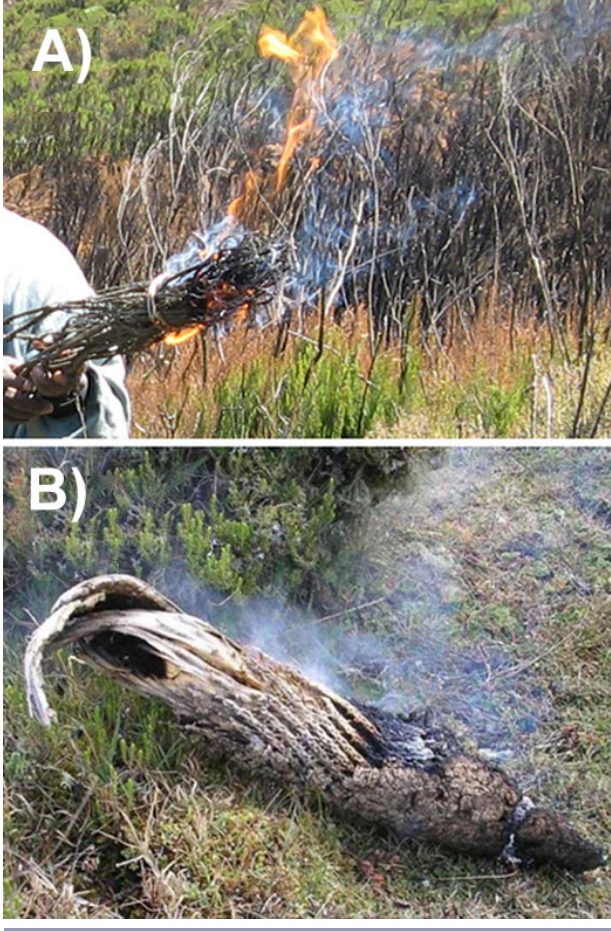
Fig. 4 . (A) A torch, “shewa,” for ignition, made of tightly bundled dry Erica shoots tied together by a Thymus schimperii stem. Note that it is the compact end of the bundle that is burning. (B) Shewa for transporting fire and for ignition, made out of a hollow giant lobelia ( Lobelia rhynchopetalum ) inflorescence stem filled by glowing embers pushed forward to activate it as a